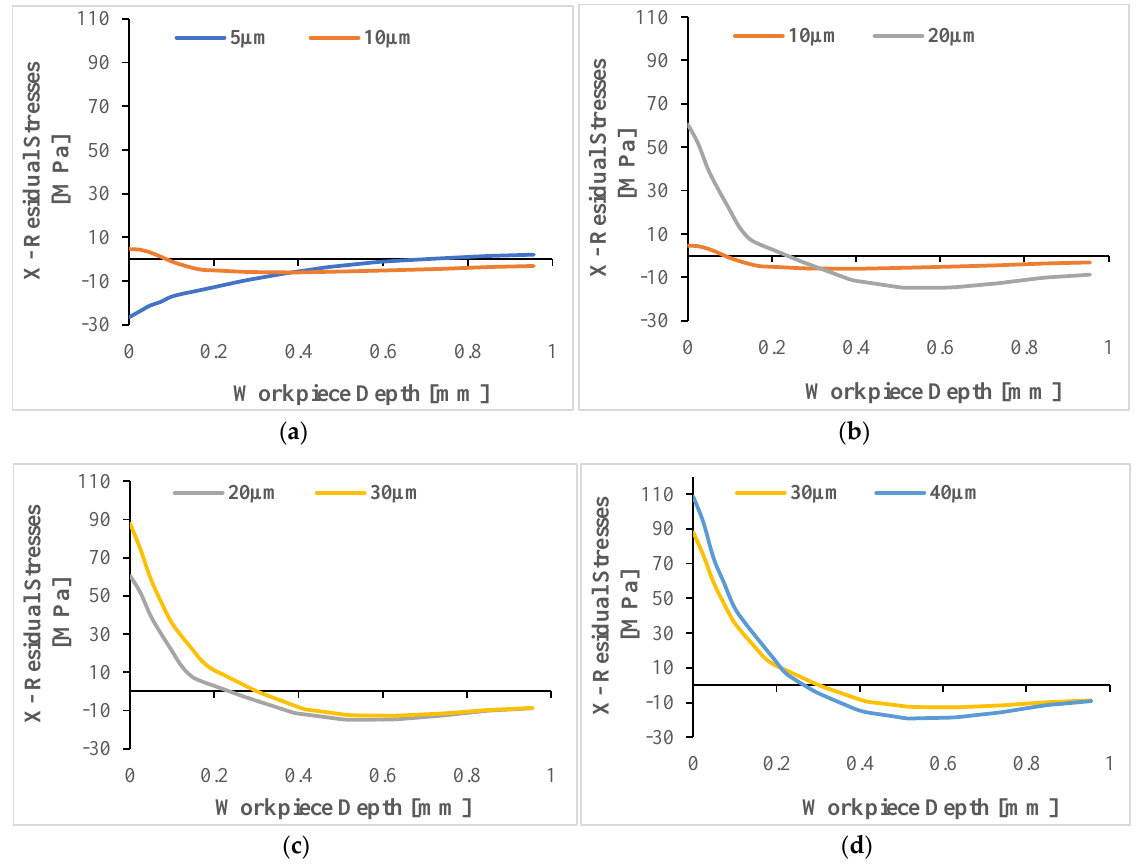
Figure 10. Effect of edge radii on residual stresses (α = 7° and γ = 17.5°). Workpiece and selected path, ( a ) 5–10 µm, ( b ) 10–20 µm, ( c ) 20–30 µm, and ( d ) 30–40 µm.